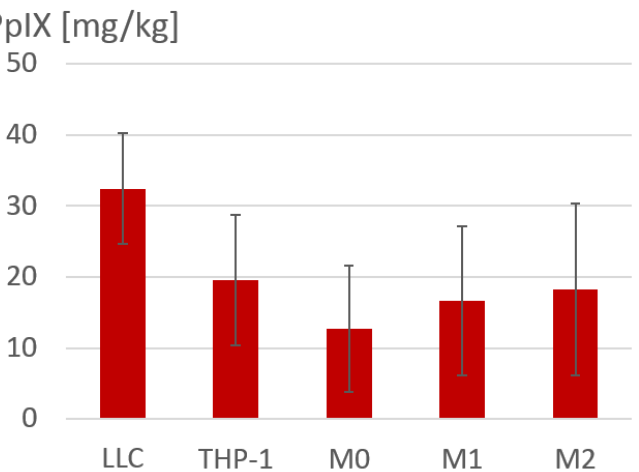
Figure 2. Accumulation of 5-ALA-induced PpIX in polarized macrophages assessed by fluorescence spectra after 4 h of incubation with 0.6 mM 5-ALA (100 mg/kg). Error bars signify the standard deviation.